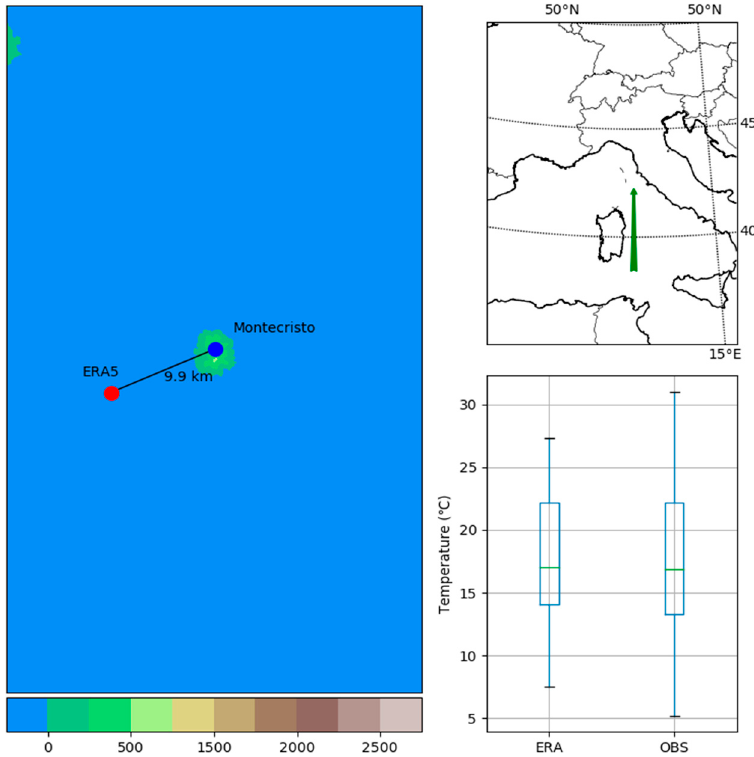
Figure 4. Altitude (m a.s.l.) and position of the Montecristo Island (Italy) automated weather station (AWS).